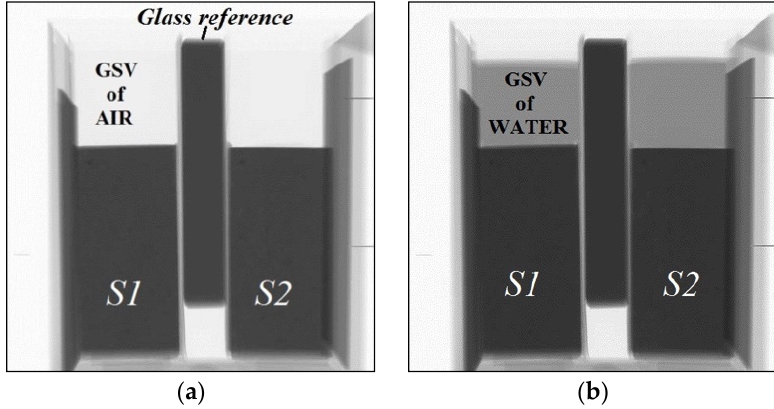
Figure 4. Difference in GSV between an empty and water filled container placed at the top of the samples S1 and S2, used for calculating attenuation coefficient of water: ( a ) GSV of an empty container; and ( b ) GSV of water ‐ filled container.